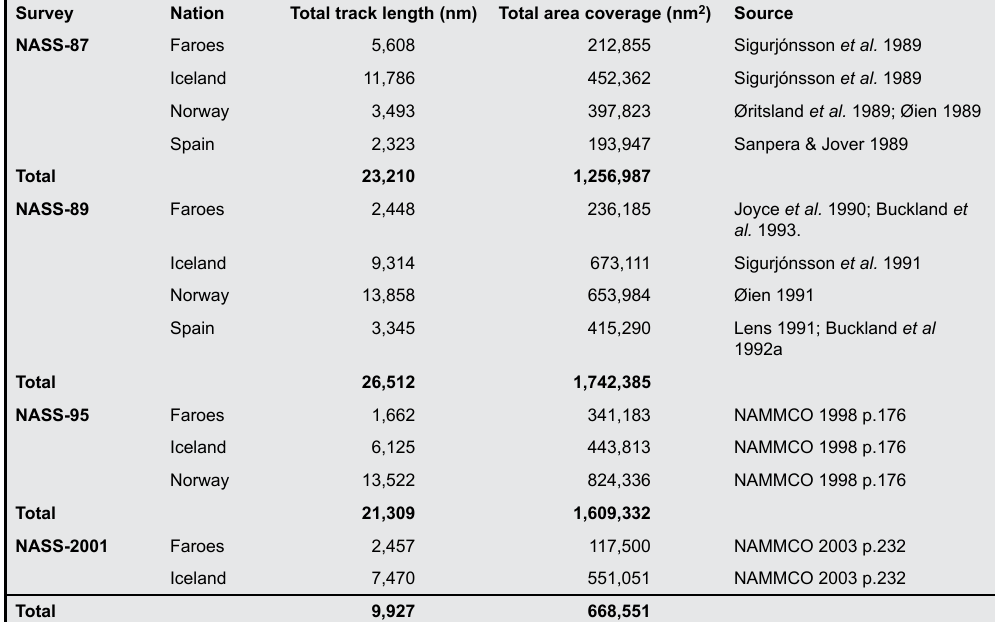
Table 3 . Total searching effort in the shipboard component of NASS 1987-2001. Survey Nation